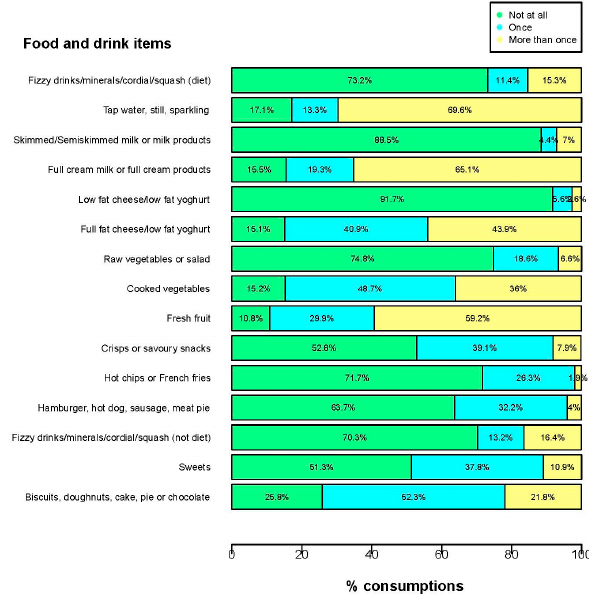
Figure 1. Food and drink items consumed in previous 24 h by the Growing Up in Ireland infant cohort at 3-years of age.